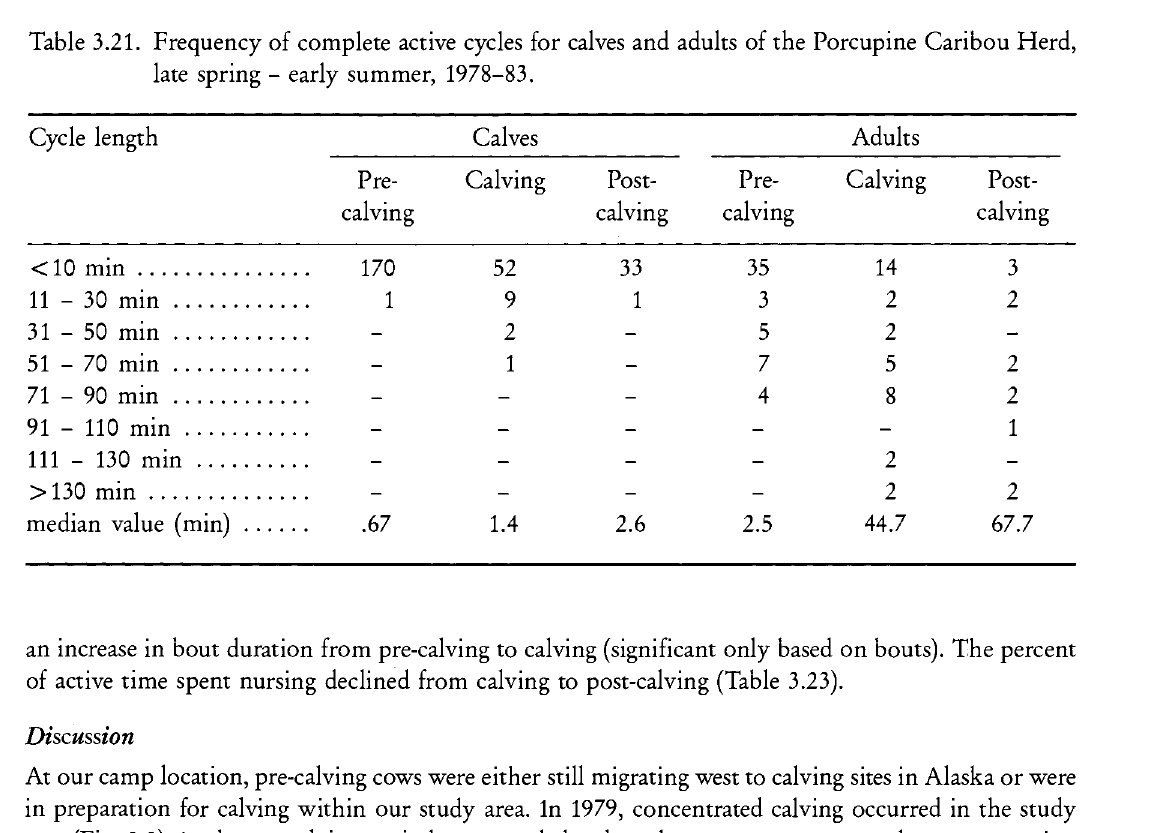
Table 3.21. Frequency of complete active cycles for calves and adults of the Porcupine Caribou Herd, late spring - early summer, 1978-83.